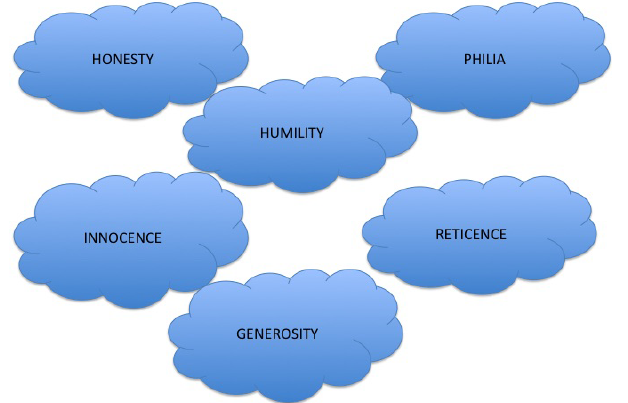
Figure 1. The scientific virtues that emerged from interviews with